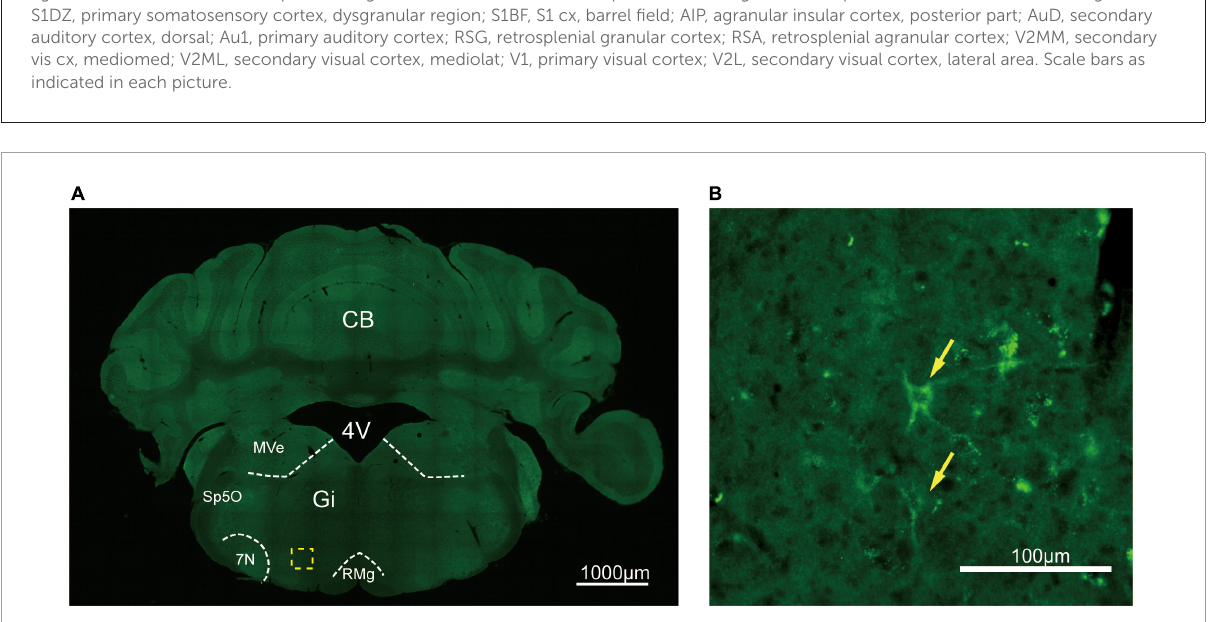
FIGURE9 Distribution of HA immunoreactivity in the gigantocellular reticular nucleus of A 2A R-tag mice. (A) Representative confocal image of HA expression in the brain (5.88 mm behind bregma). The labeled cell could be seen in the Gi. (B) High magnification of the area in yellow indicated in panel (A) . Discrete labeled cells (arrows) could be seen. CB, cerebellum; 4V, 4th ventricle; MVe, medial vestibular nucleus; Sp5O, spinal trigeminal nucleus, oral part; 7N, facial nucleus; Gi, gigantocellular reticular nucleus; RMg, raphe magnus nucleus. Scale bars as indicated in each